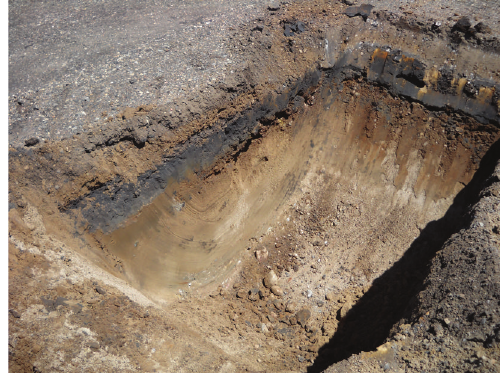
Figure 4: Example test pit showing, from top to bottom, typical soil profile: residual gray base aggregate, brown silty sand, black organic silt, brown silty sand.